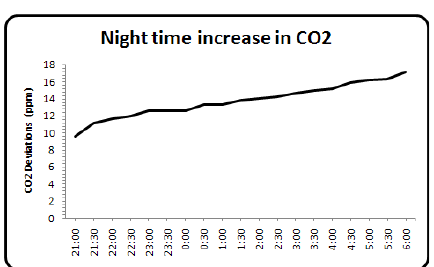
Figure.4 CO 2 variations observed between 04-07 hr LT during different months in 2009.